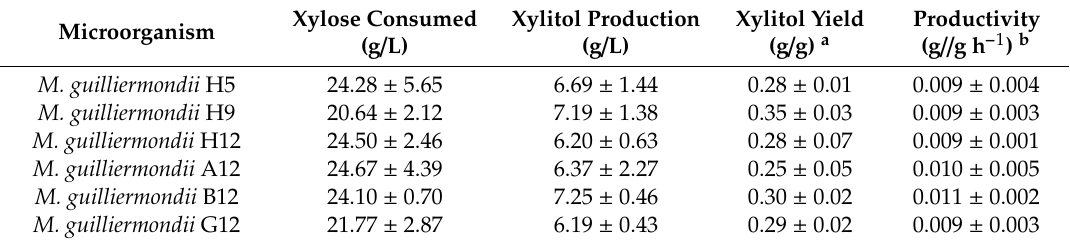
Table 2. Xylitol production by selected Meyerozyma strains in shake-flasks under oxygen-limited conditions in a defined medium. Xylitol production, yield, and productivity after 72 h of incubation. Values are average and deviation from duplicate experiments.